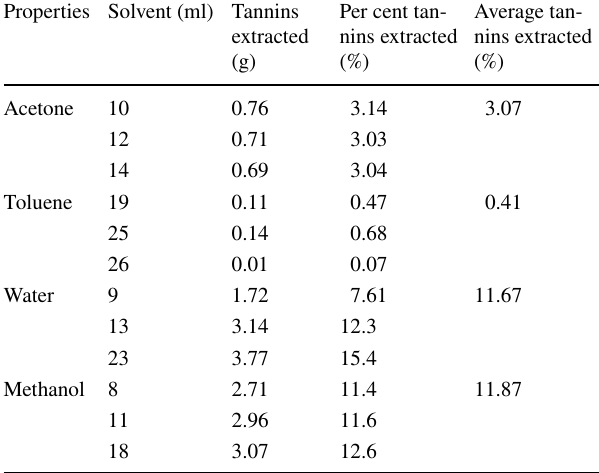
Table 2 Per cent yield of tannins extracted with different solvents Properties Solvent (ml) Tannins extracted